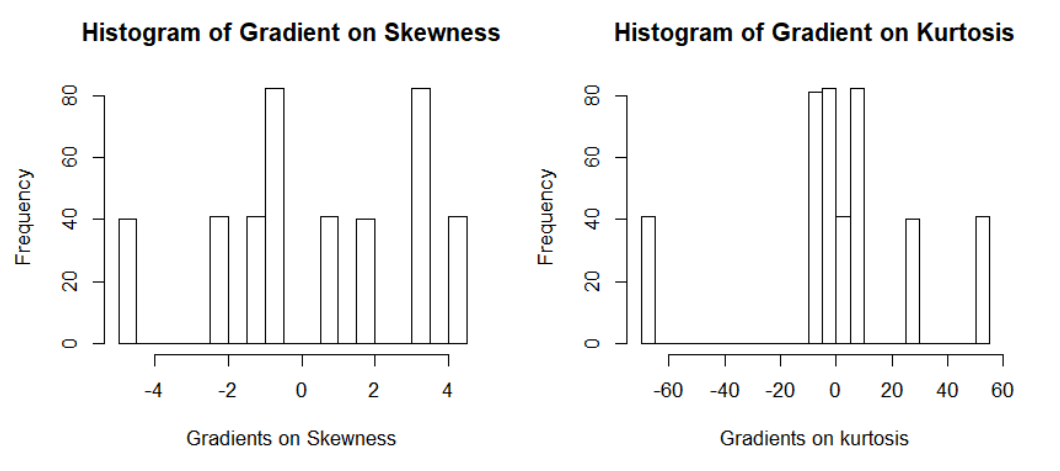
Figure 9. Histograms of spline gradients (Step 4).